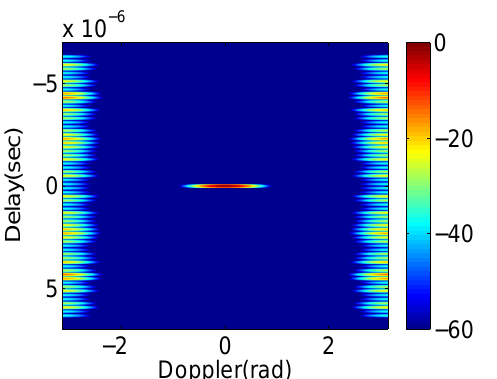
Figure 2. The ambiguity function of complementary sets using the BD algorithm. (unit in the colorbar is